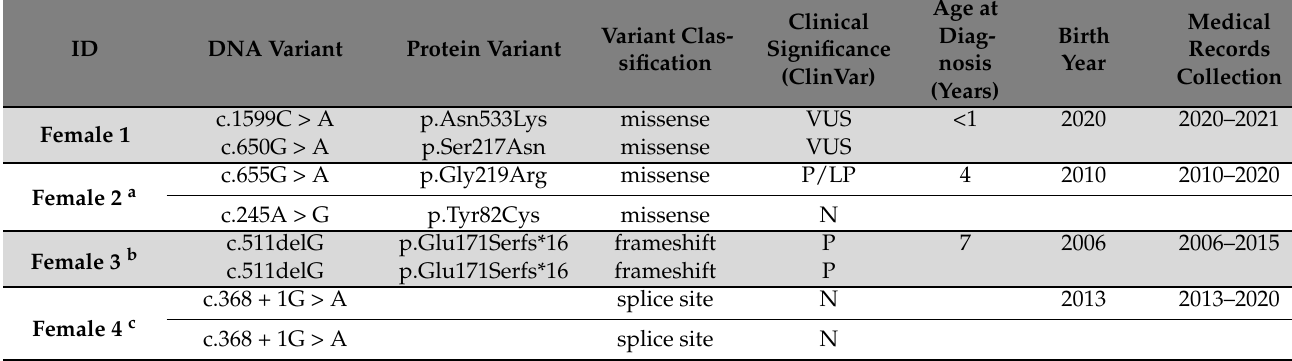
Table 1. SLC13A5 Citrate Transporter Disorder patient demographics. a siblings, b siblings, c siblings, d siblings. Clinical significance based on ClinVar. P: pathogenic, LP: likely pathogenic, VUS: variant of uncertain significance, N: not found in ClinVar database at time of